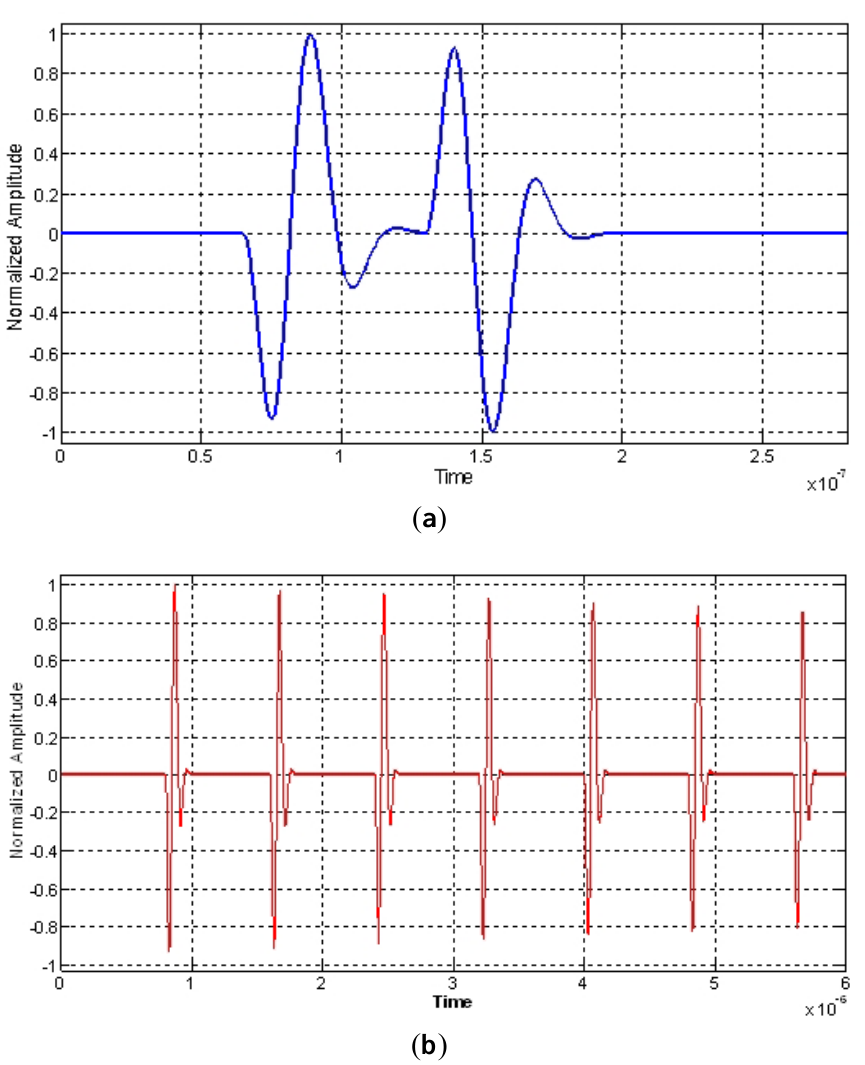
Figure 5. Simulated multi-pulse echoes based on a simple mathematical model of regularly spaced reflectors, emulating: ( a ) two parallel membranes (separated around 50 microns) in an amniotic sac or in a pleura using a 30 MHz pulse; ( b ) uniform reflectors distribution in an ideal tissue (10 MHz